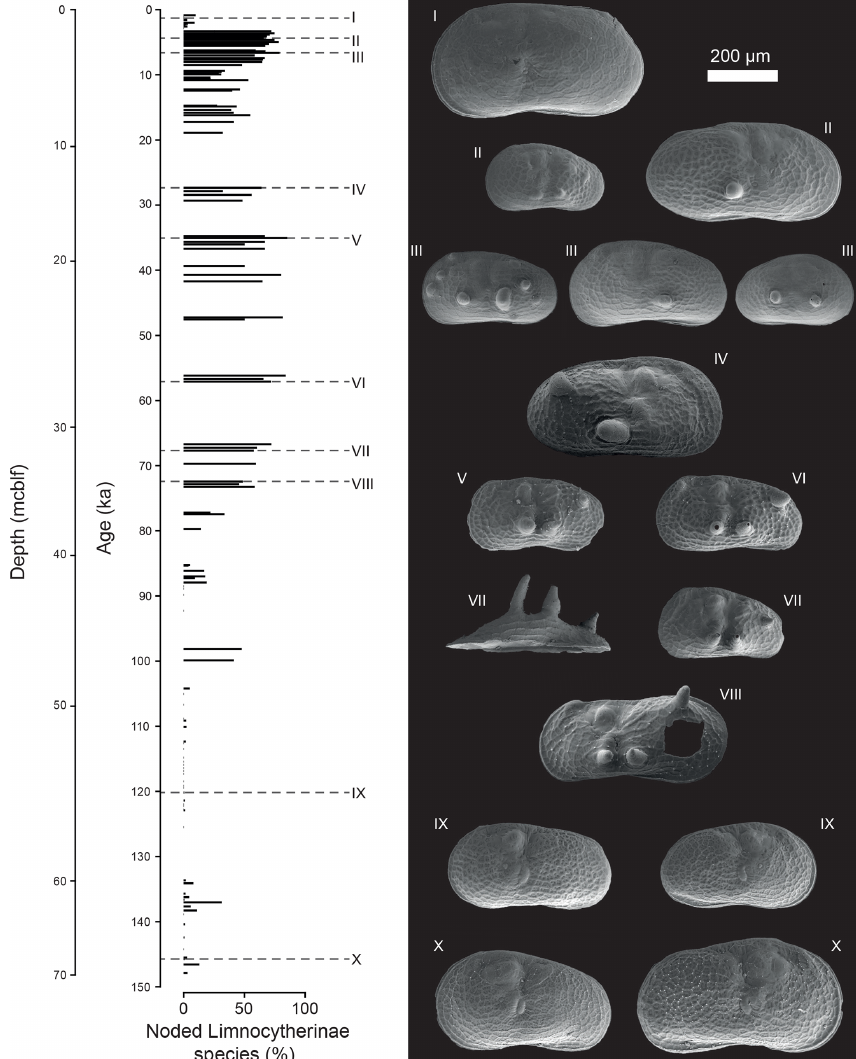
Figure 4. Illustration of number and intensity of noded Limnocytherinae species valves (as SEM images) within the studied interval. Roman numerals indicate the depth and age of individual valves. The valves displayed here are both from adult and juvenile